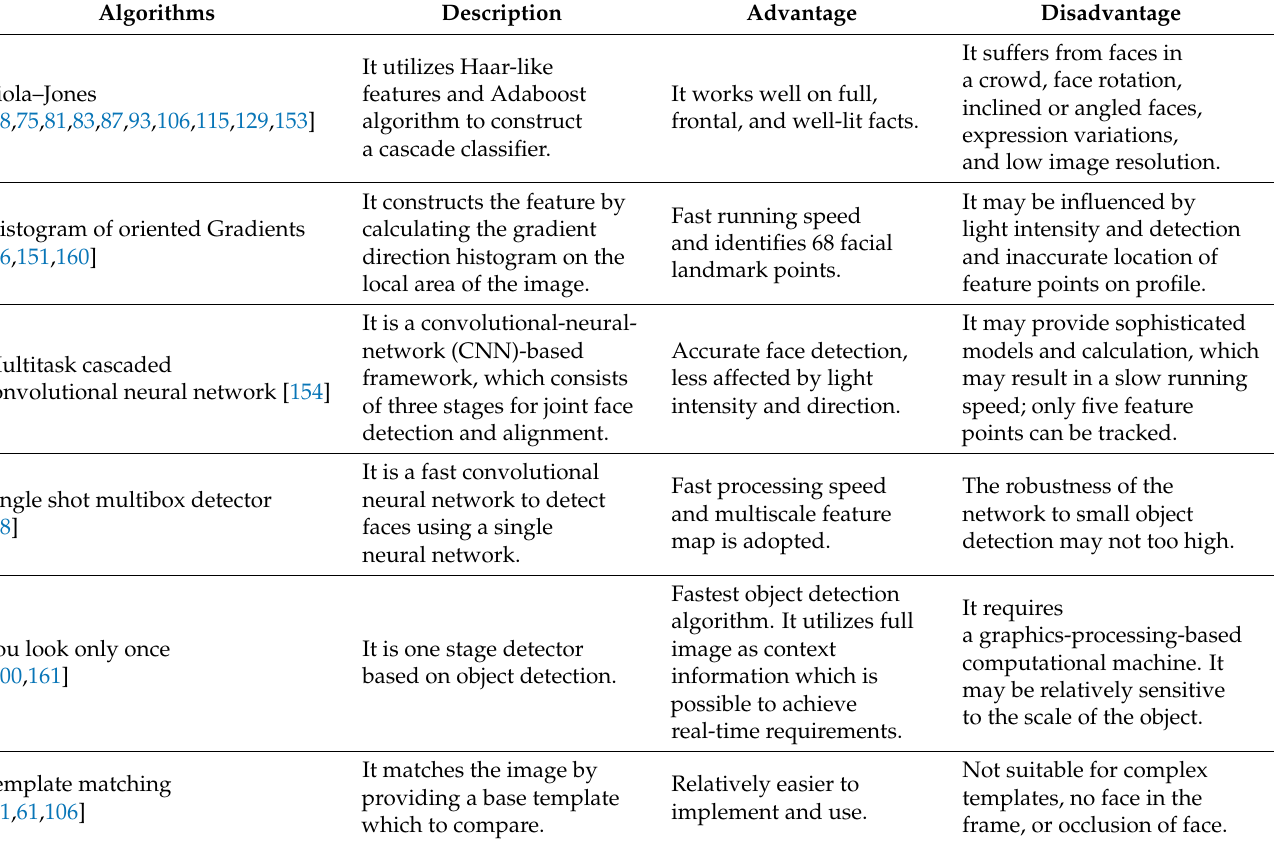
Table 3. Automatic detection of ROI by utilizing various classical and DL